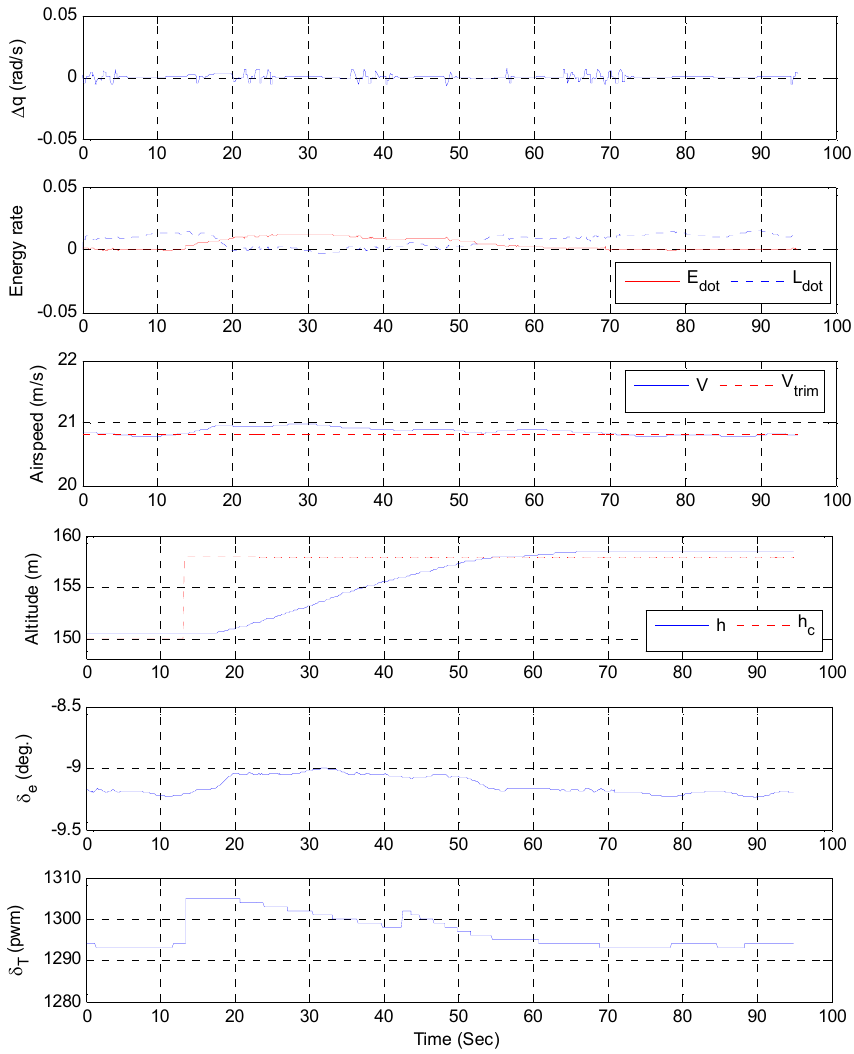
Figure 15. Simulation results of climbing without the presence of wind.